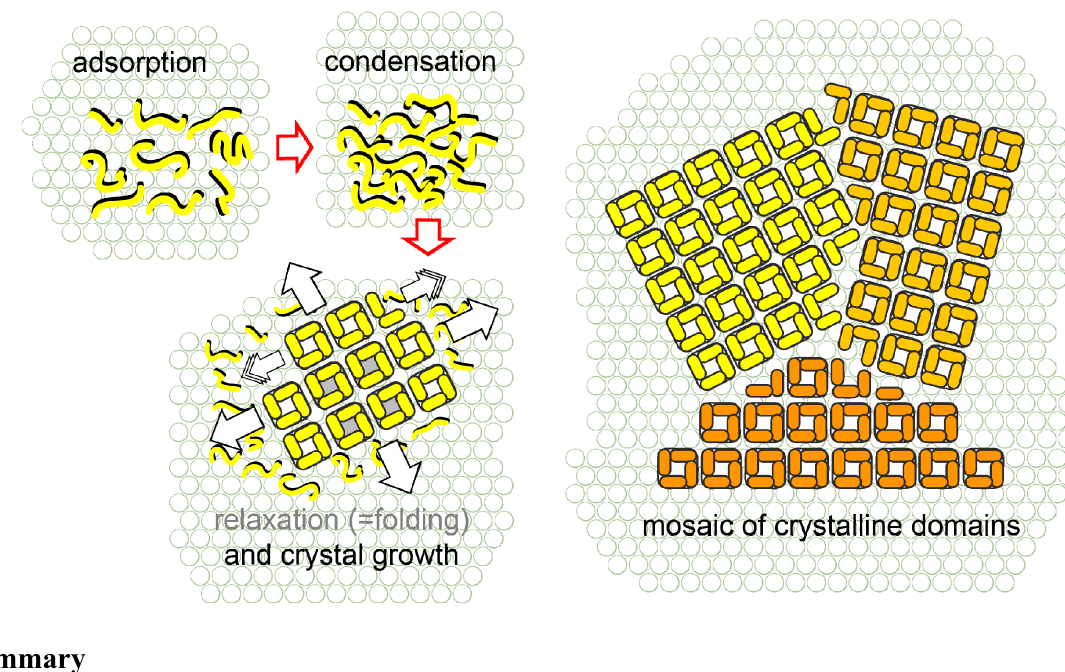
Figure 5 . Schematic drawing of the reassembly pathway of the S-layer protein SbpA from L. sphaericus on supported lipid films (drawn after description in ref.